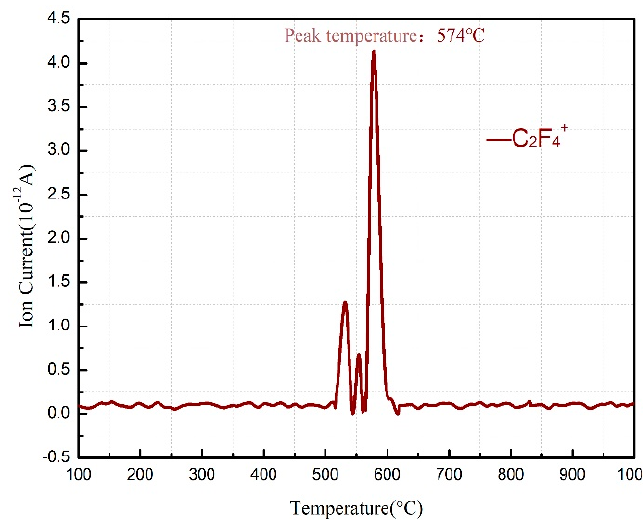
Figure 2. Mass spectrometry (MS) spectra of C 2 F 4+ in PTFE/Al sample.